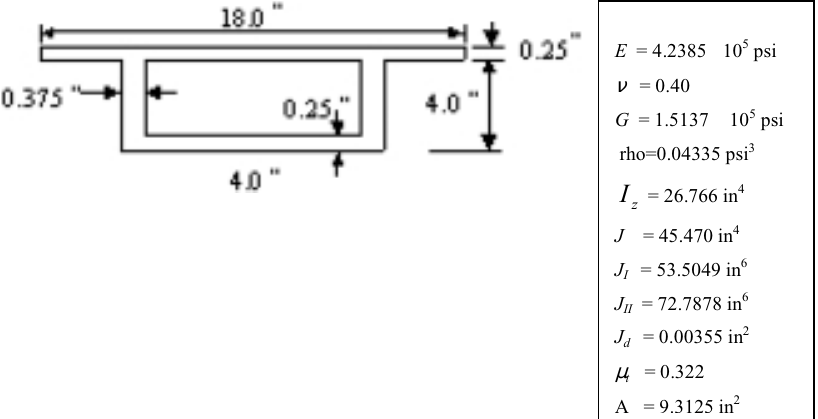
Fig. 3. Geometry (inch) and properties of the box girder model.